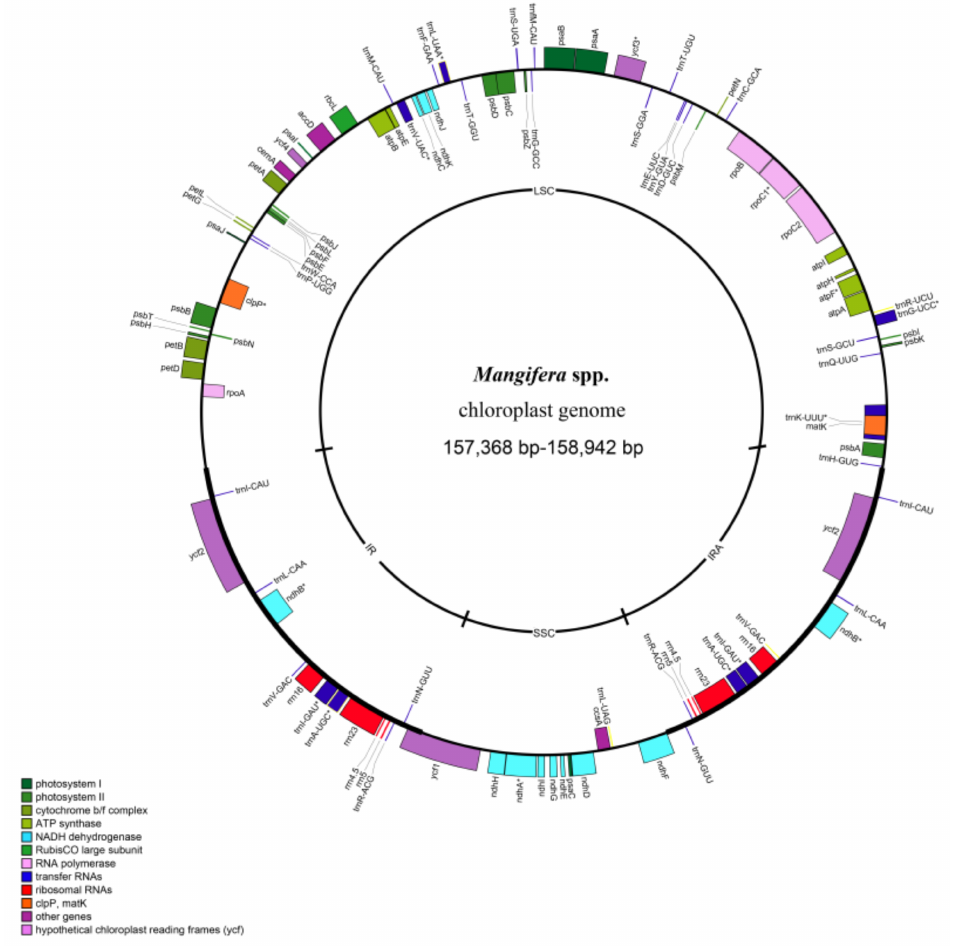
Figure 1. Gene map of the chloroplast genome of 11 species of Mangifera . Genes inside and outside the circle are transcribed in a clockwise and counterclockwise direction, respectively. Genes are colour-coded based on their function. The grey area in the inner circle indicates the GC content of the chloroplast